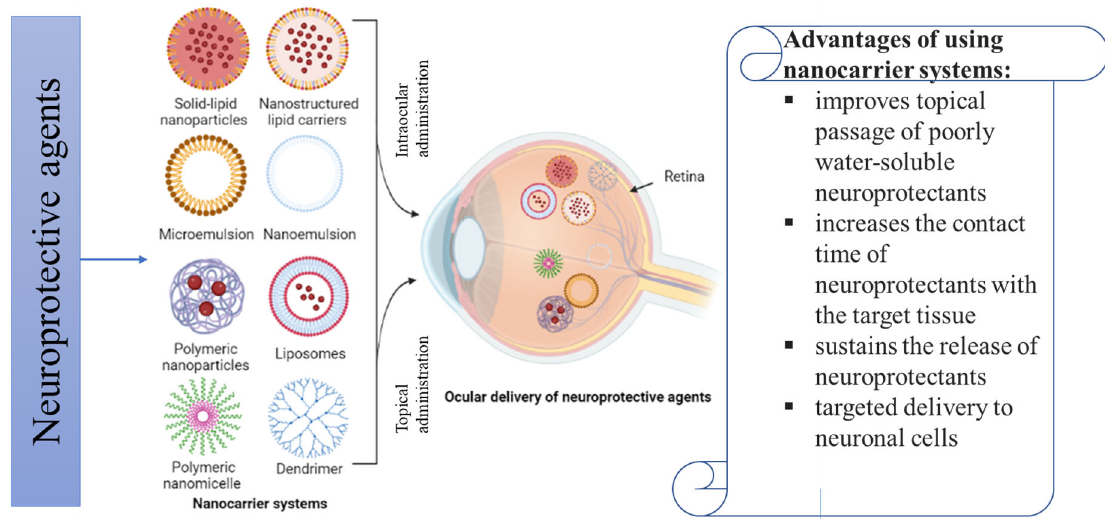
Figure 4. Nanocarriers systems for the ocular delivery of neuroprotective agents in the treatment of ocular neurodegenerative diseases. Image was created in BioRender.com.